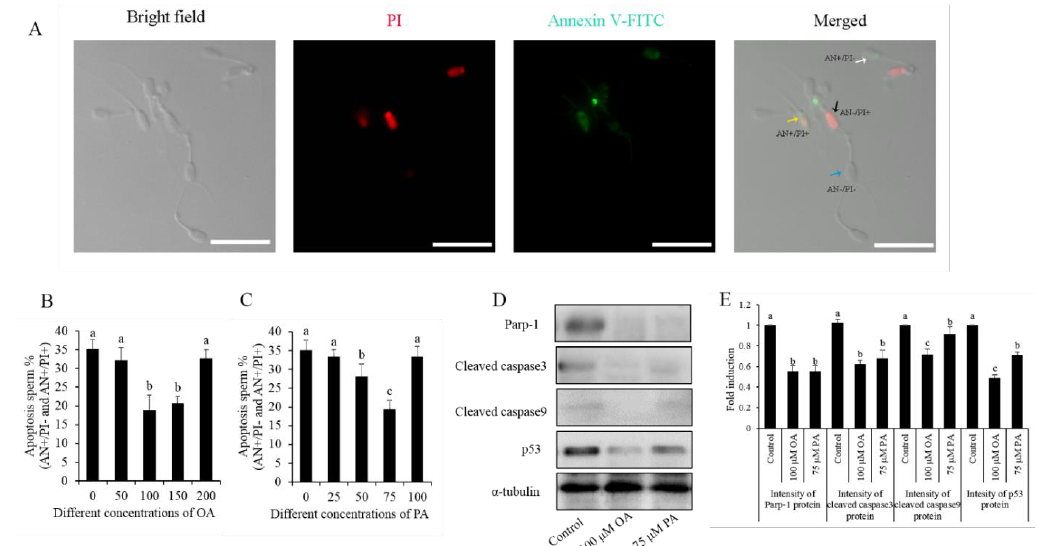
Figure 4. (A) Photomicrographs of the boar sperm stained with the Annexin V-FITC/PI assay kit: live sperm (AN-/PI-; blue arrow); early apoptotic sperm (AN+/PI-; white arrow); late apoptotic sperm (AN+/PI+; yellow arrow); and non-viable necrotic sperm (AN-/PI+; black arrow). Effects of different concentrations of OA (B) and PA (C) on boar sperm apoptosis. The Western blotting image shows the expression of apoptosis proteins in boar sperm after being treated with OA and PA (D). (E) Quantitative expression of the Parp-1, cleaved caspase-3, cleaved caspase-9, and p53 over α-tubulin generated from Western blotting (D). Data are the mean ± standard deviation (SD). Columns with different lowercase letters differ significantly ( p ＜ 0.05). Bars = 30 μm.